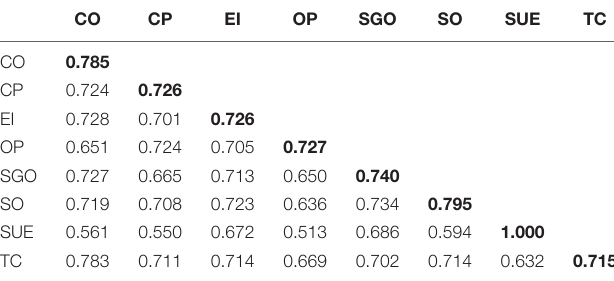
TABLE 4 | Discriminant validity (Fornell and Larcker criterion).